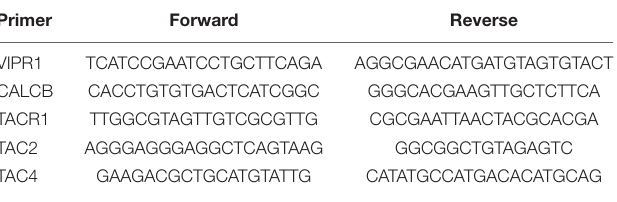
TABLE 1 | Sequences of primers used for quantitative RT-PCR